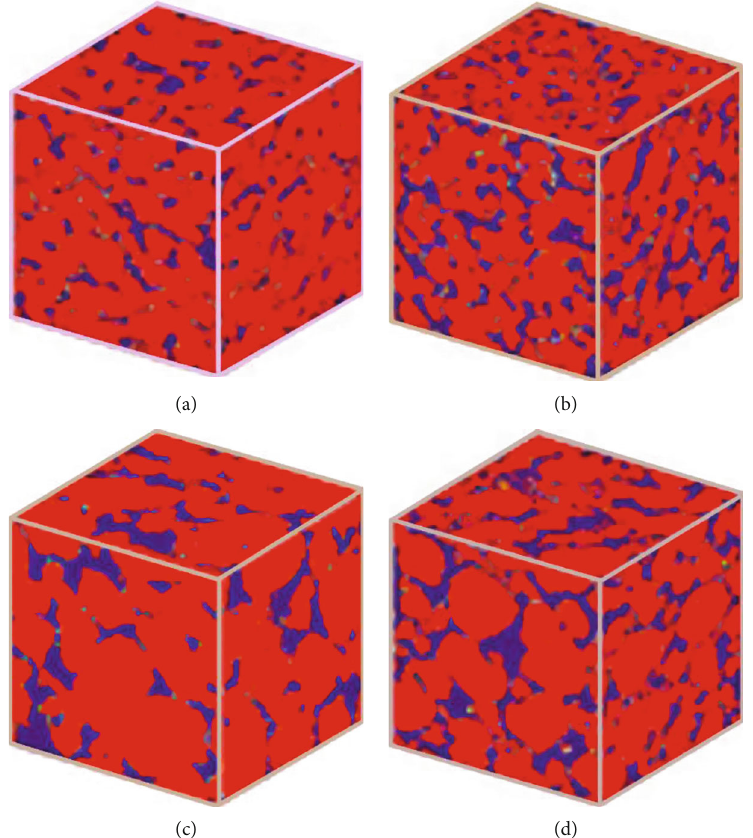
Figure 2: Three-dimensional sandstone pore network. The porosities are (a) 14.1%, (b) 21.1%, (c) 24.6%, and (d)